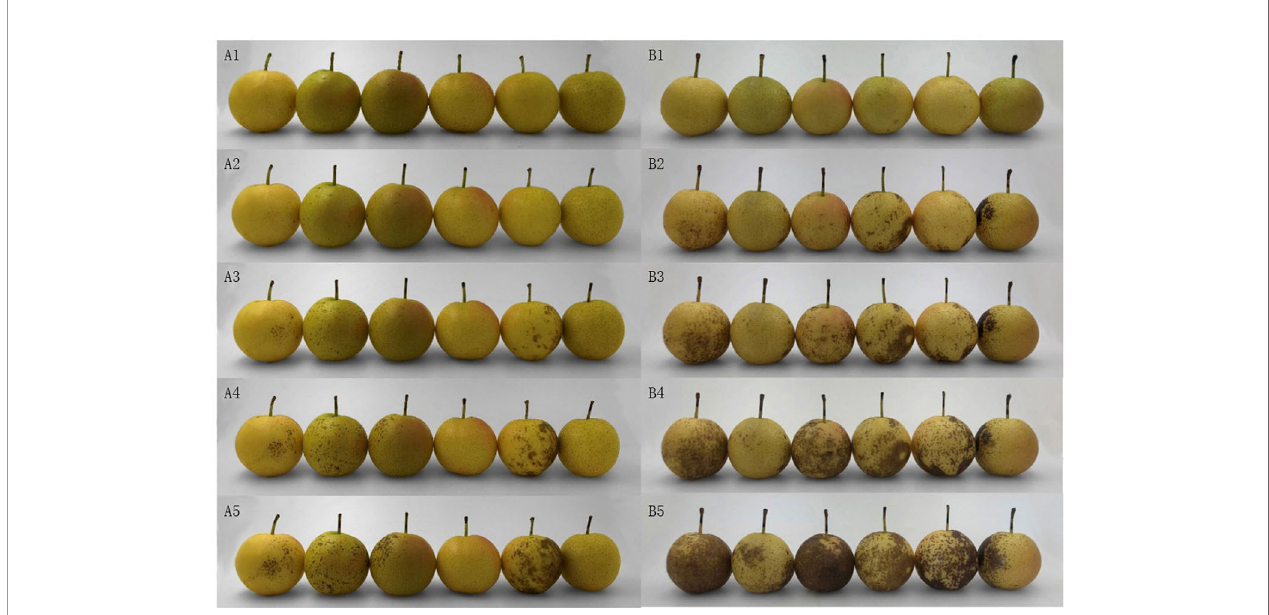
FIGURE 1 | Pericarp browning during shelf life of CaCl 2 -treated (A1, A2, A3, A4, A5) and control (B1, B2, B3, B4, B5) ‘ Nanguo ’ pears after 180 days of cold storage. 1, 2, 3, 4, and 5 represent 0, 3, 6, 9, and 12 days of shelf life,